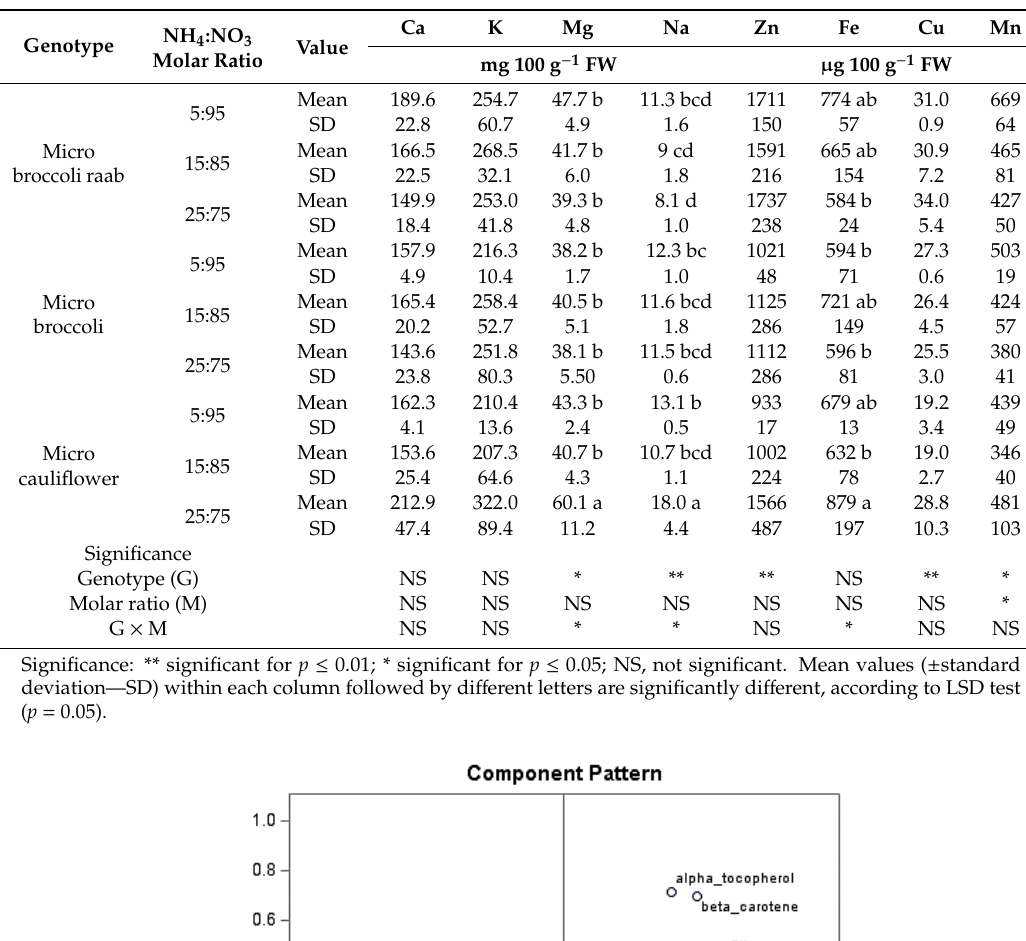
Table 3. Elements content in Brassica microgreens grown by using a nutrient solution with three NH 4 :NO 3 molar ratios.